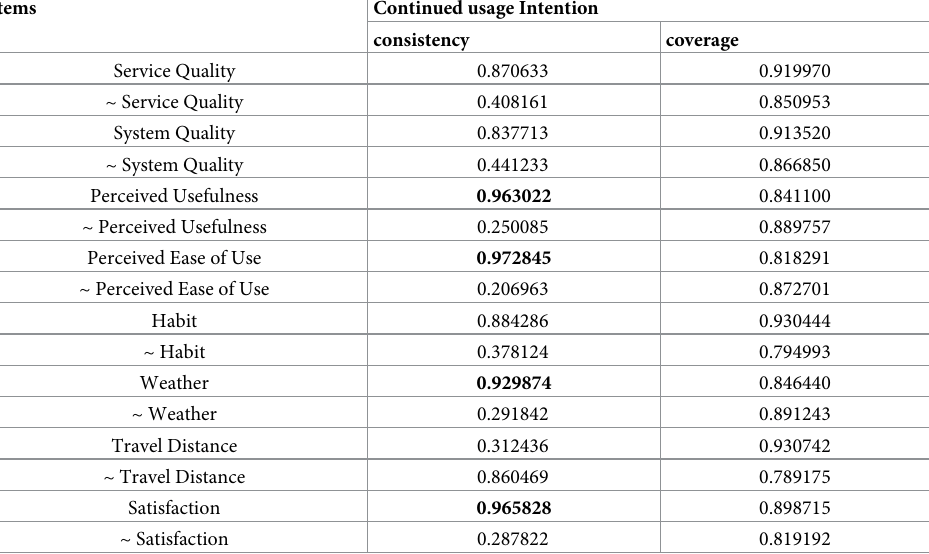
Table 6. Necessary conditions from